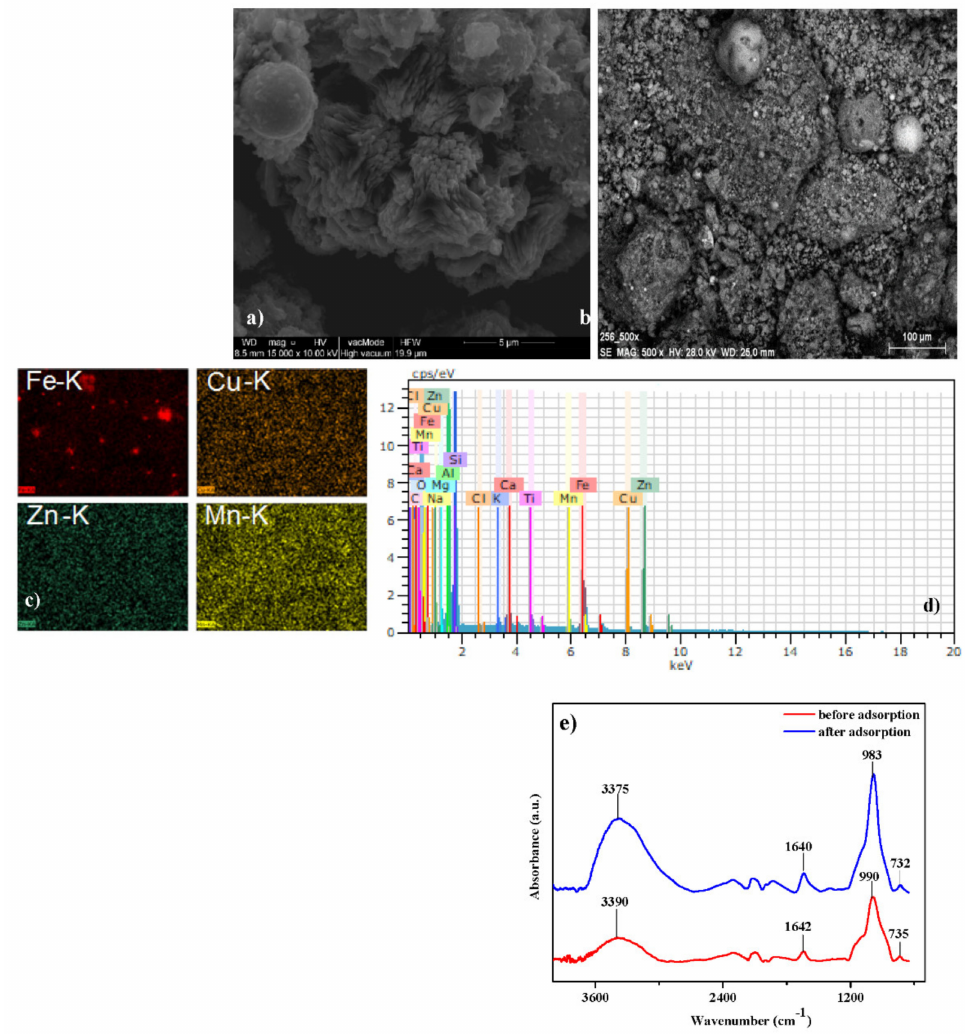
Figure 5. ( a ) SEM image of the NaP1, ( b ) NaP1CS after adsorption of Cu(II), Fe(III), Mn(II), and Zn(II) complexes with IDHA and corresponding X-ray maps ( c ) as well as ( d ) EDS spectra collected onto NaP1CS after adsorption of Cu(II), Fe(III), Mn(II), and Zn(II) complexes with IDHA and ( e ) FTIR spectra of NaP1CS before and after the adsorption process of Cu(II) in the presence of